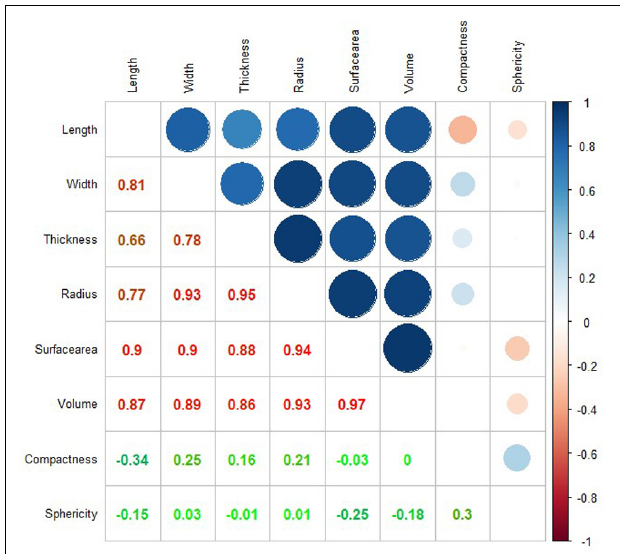
FIGURE 5 | Pairwise-correlation coefficients among eight morphological phenotypes of soybean